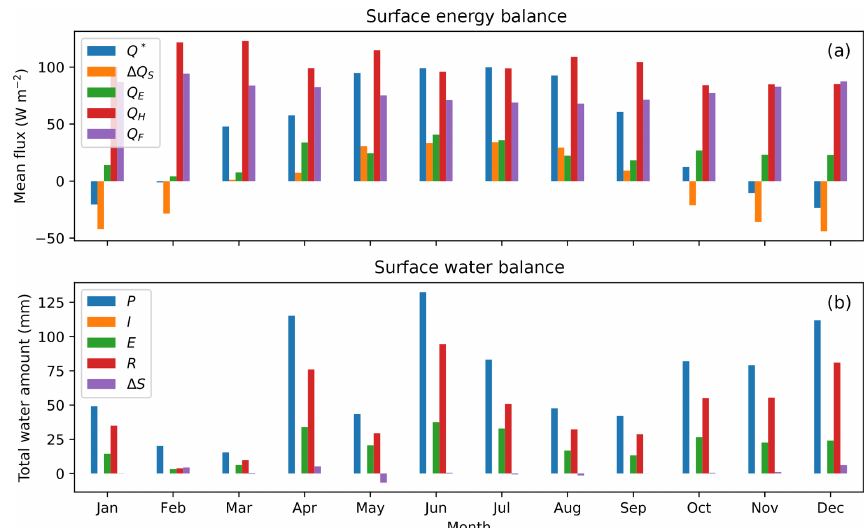
Figure 3. SuPy simulated monthly (a) surface energy and (b) water balance for London 2012. Assuming no irrigation.